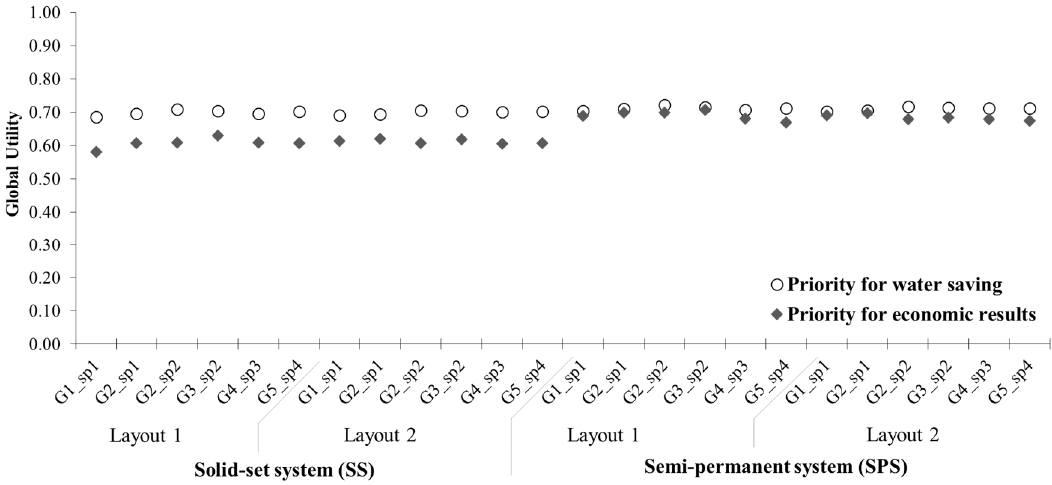
Figure 8. Global utility values relative to solid set and semi ‐ permanent sprinkler systems when the priority is assigned to water saving or to economic results. Layouts are defined in Figure 4, and sprinkler spacing (G1, 2, …, 5) and sprinkler types (sp1, 2, …, 4) are identified in Table